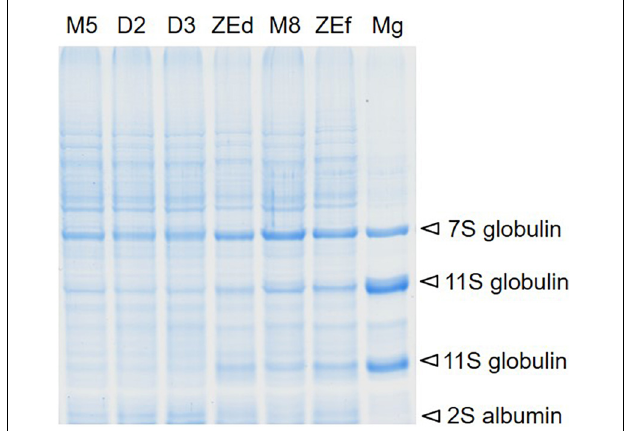
FIGURE 4 | Representative SDS-PAGE total protein profile comparison in somatic (SEs) and zygotic (ZEs) embryos of P. abies. The location of major storage proteins identified by mass spectrometry in SEs, dry ZEs and the megagametophyte (Mg) in the protein pattern is shown by arrows. Line M5 – SEs after 5 weeks of maturation, line M8 – SEs after 8 weeks of prolonged maturation, line D2 – SEs after 2 weeks of desiccation, line D3 – SEs